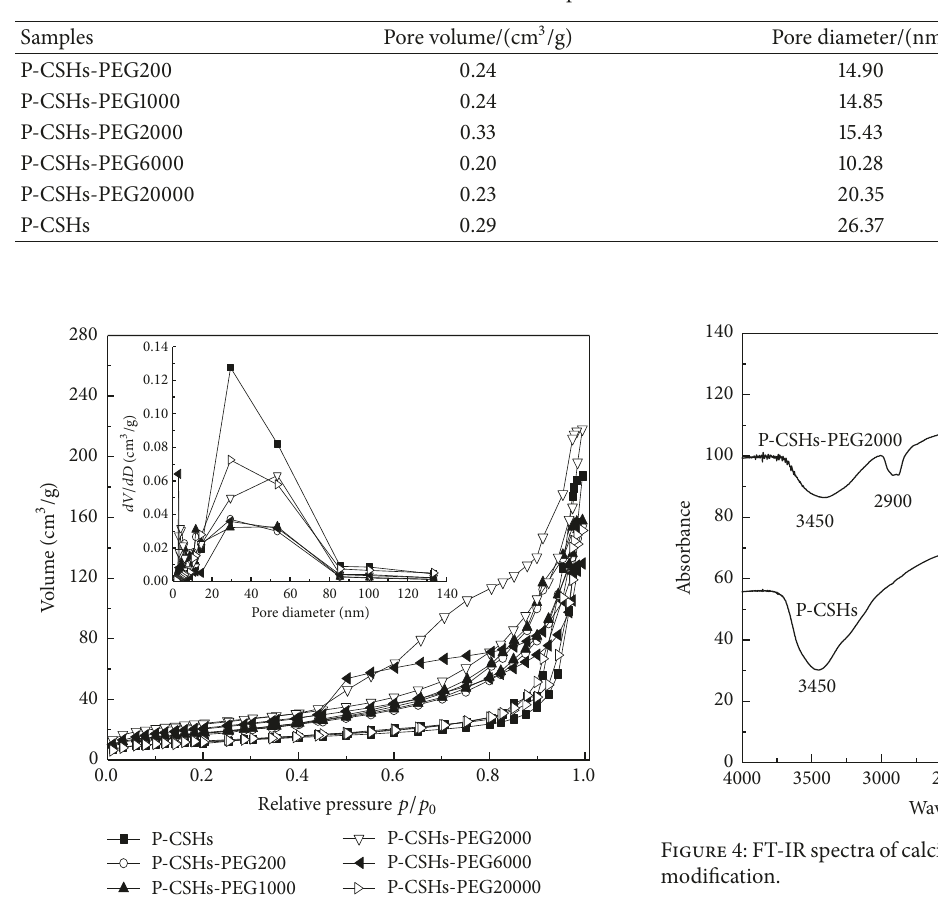
Figure 3: The N 2 adsorption-desorption isotherms and pore-size distribution curves for different materials.